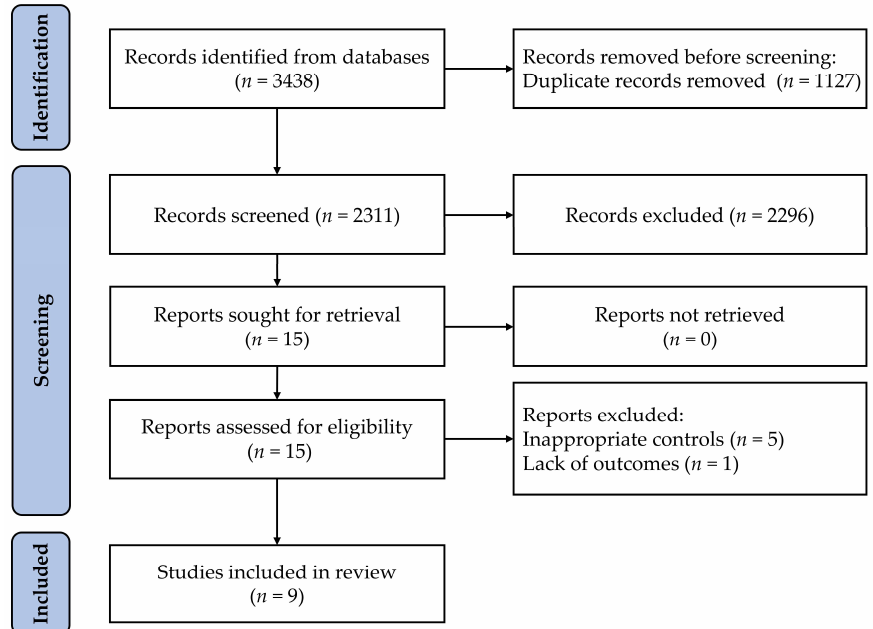
Figure 1. Flow diagram of the screening and selection of studies.